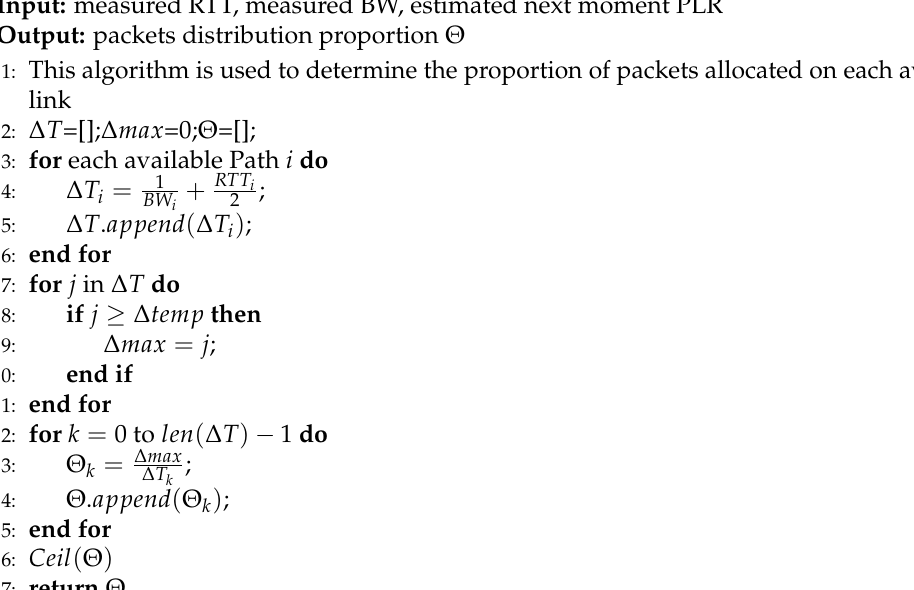
Algorithm 1 Coded packets